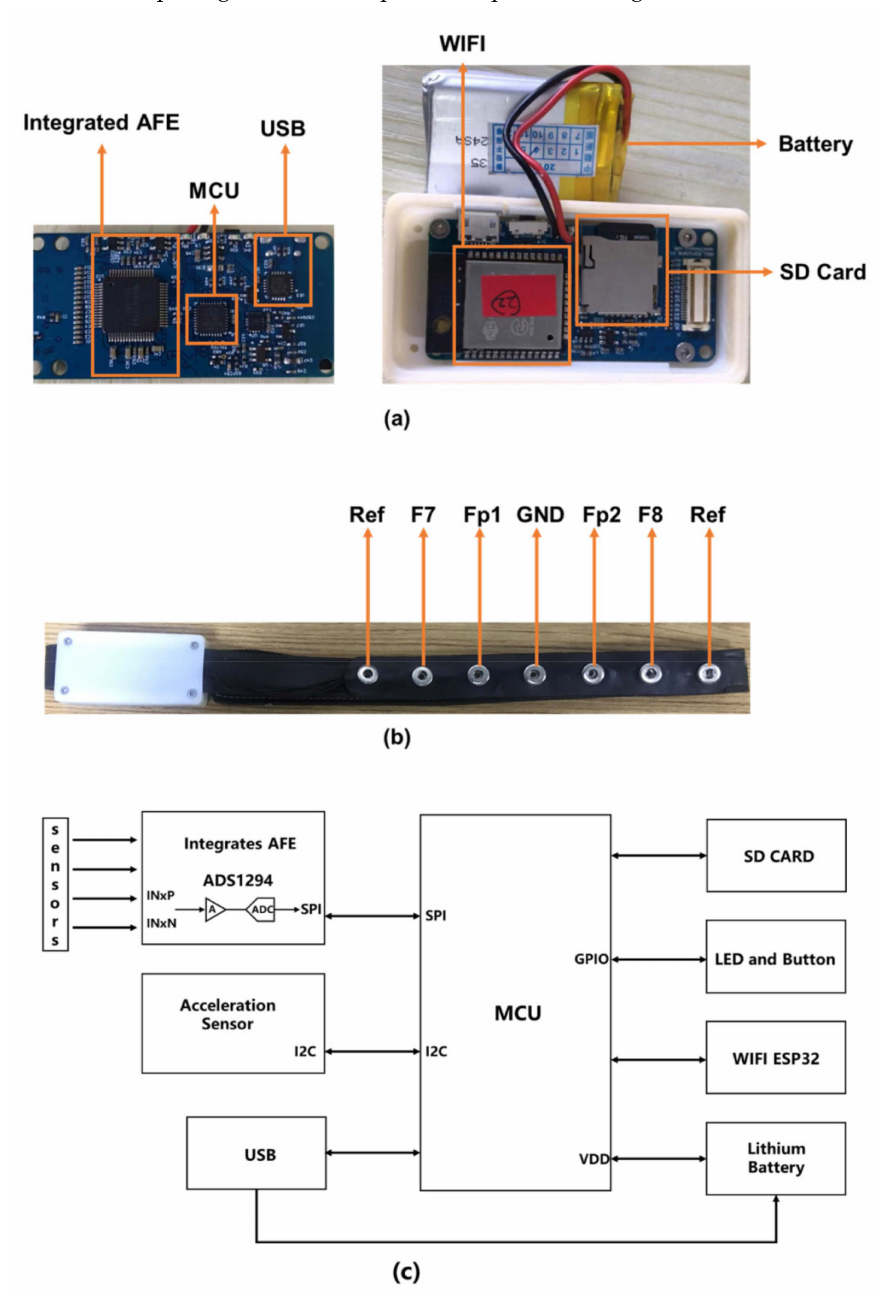
Figure 1. Wearable frontal lobe EEG device, Mindeep. ( a ) Hardware circuit; ( b ) shape design and electrode location of the wearable frontal EEG device Mindeep; and ( c ) circuit diagram of